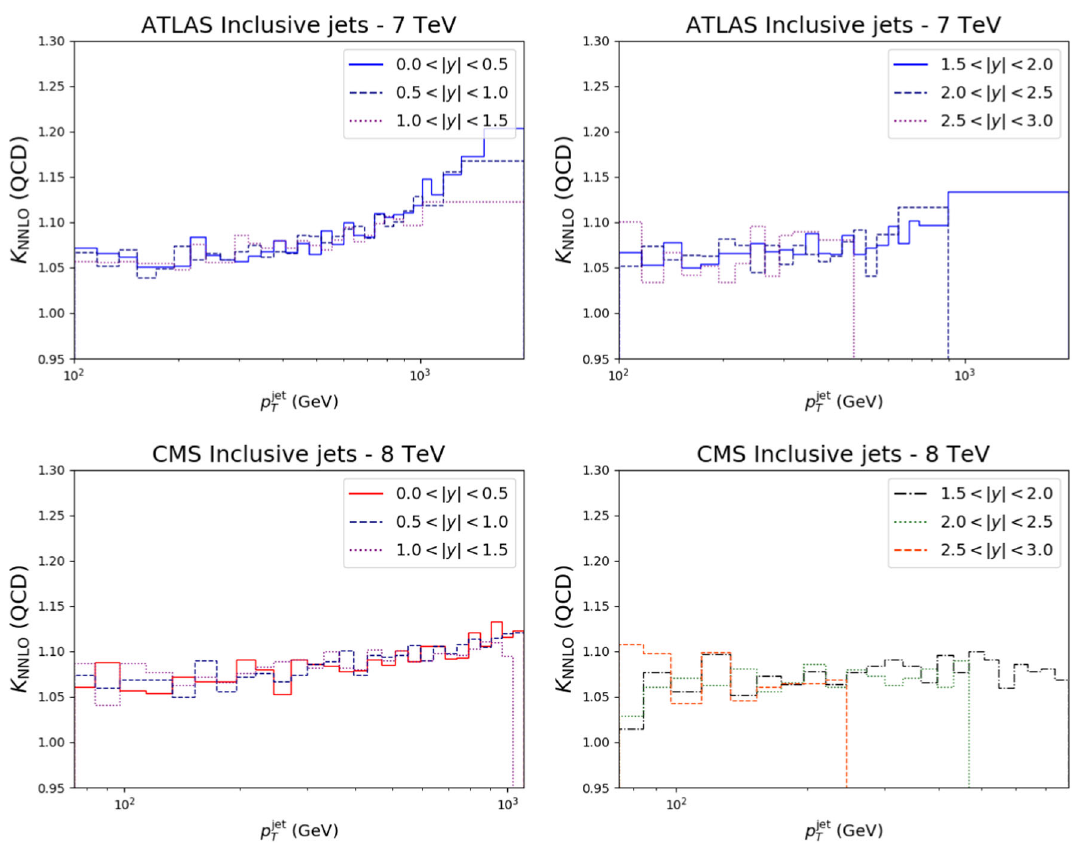
Fig. 1 The NNLO QCD K -factors, Eq. (3.2), for the ATLAS 7 TeV (top) and CMS 8 TeV (bottom) single-inclusive jet cross-sections eval- uated using NNPDF3.1 PDFs and scale μ = (cid:2) H T . Results are shown as